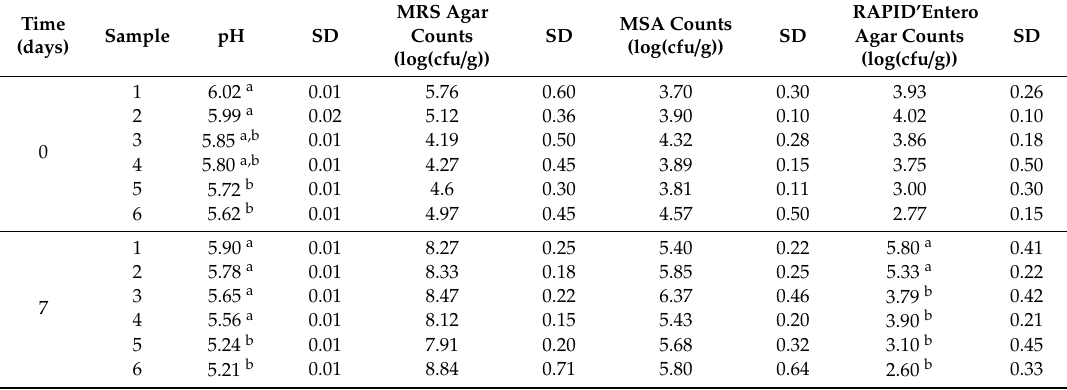
Table 1. Community dynamics of the microbiota of naturally fermented pork mince and the resulting pH course after 0 and 7 days of fermentation and standard deviation (SD). The bacterial counts on de Man-Rogosa-Sharpe (MRS) agar, mannitol salt-phenol red-agar (MSA), and RAPID’Enterobacteriaceae agar (RAPID (cid:48) Entero agar) are expressed as log (cfu / g). Data sets with superscripts were significantly heterogeneous according to ANOVA; within each sampling time, means sharing the same superscript were not significantly di ff erent from each other using post-hoc